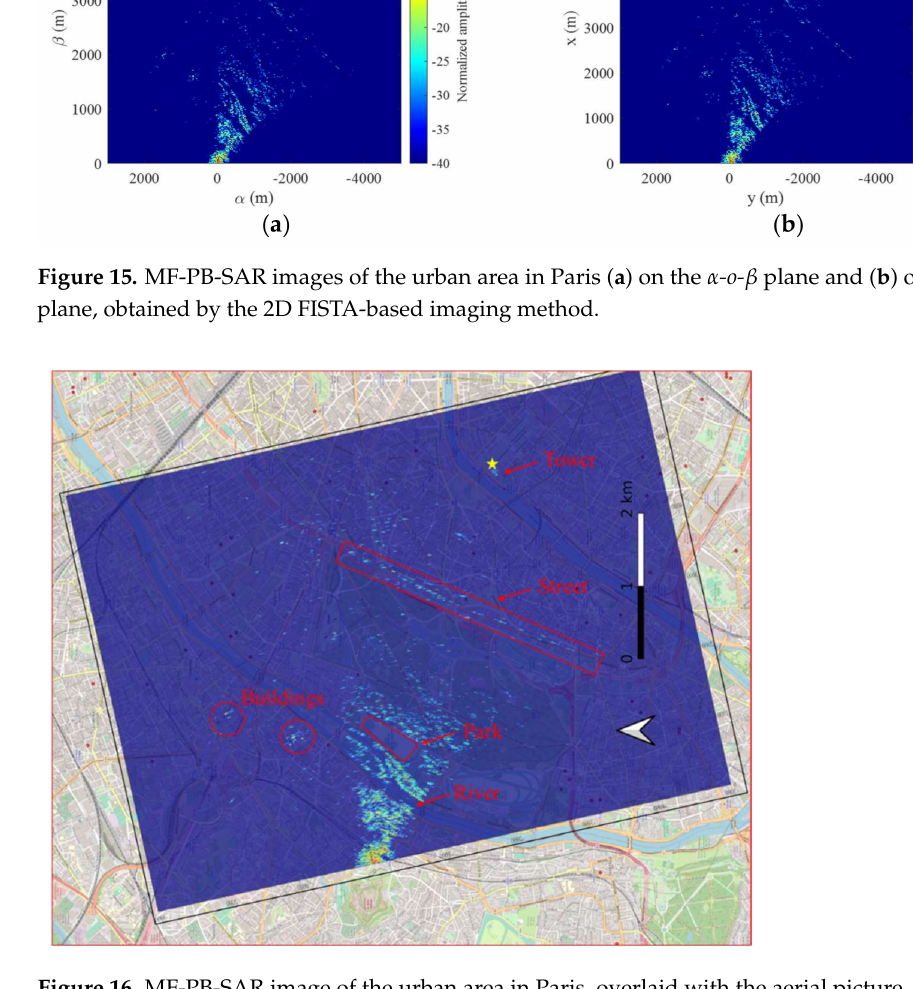
Figure 16. MF-PB-SAR image of the urban area in Paris, overlaid with the aerial